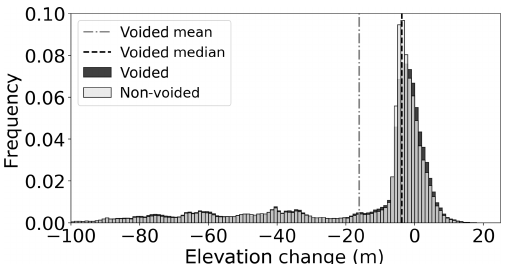
Figure 9. Distribution of elevation change values for voided and non-voided datasets over Field Glacier, binned using 1m bins. Ver- tical lines indicate mean and median values for the voided dataset.